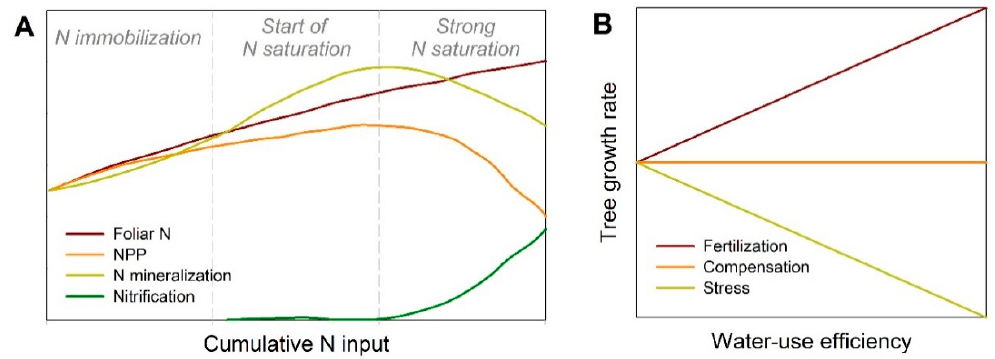
Figure 2. ( A ) Hypothetical responses of temperate forest ecosystems to long-term external N inputs in terms of foliar N, net primary production (NPP), and N biogeochemical processes, including N mineralization, nitrification, and leaching losses (adapted from [88]). ( B ) Expected relationships between water-use efficiency (WUE) and tree growth (adapted from [56]). When increased WUE, resulting from rising atmospheric CO 2 concentrations and/or water stress can override the physiological response to stress, a CO 2 fertilization effect on growth is expected (Fertilization). Conversely, if water, nutritional, or other type of stress is too strong, a negative growth-WUE would occur (Stress). No change is expected when CO 2 stimulation compensates for stress (Compensation).